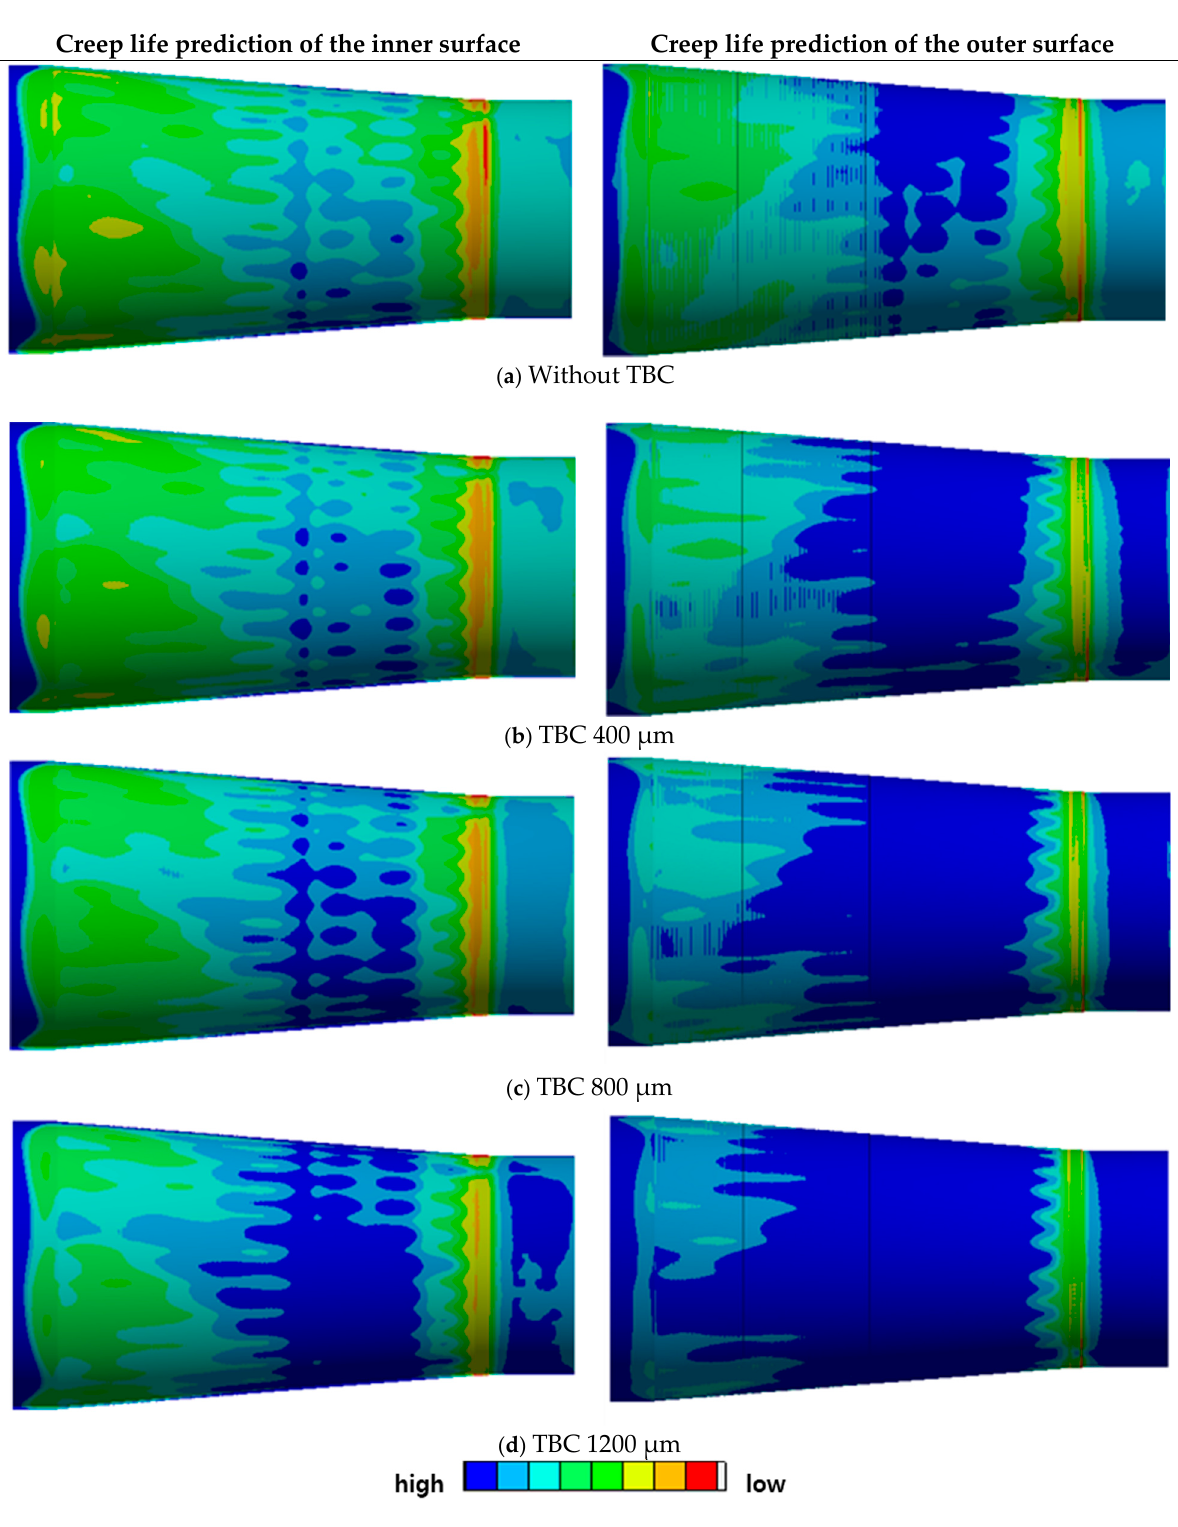
Figure 19. Surface stress (×10 7 Pa) distribution on the combustor liner based on TBC thickness.